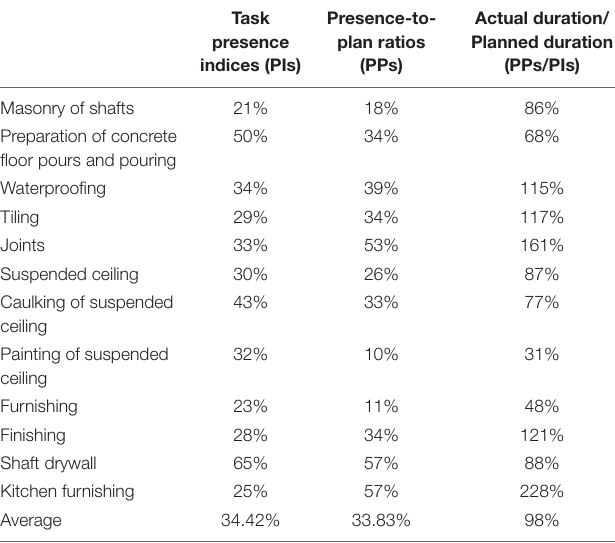
TABLE 7 | Results of PIs, PPs in all tracked tasks and their